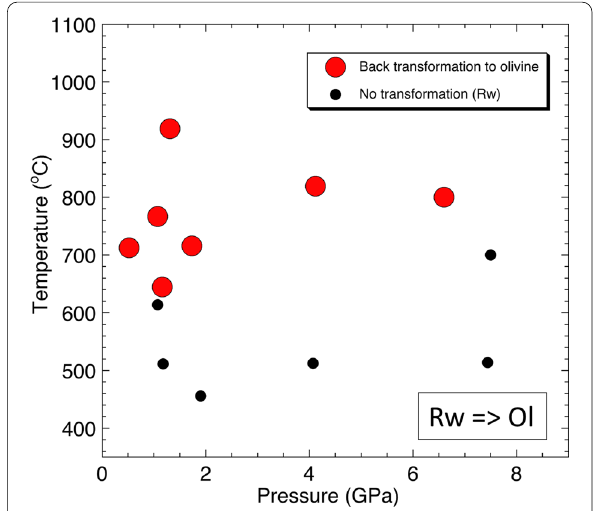
Fig. 2 P–T conditions for the back-transformation in ringwoodite. The back-transformation to olivine occurred at higher than ~ 600–700 °C (red circles)